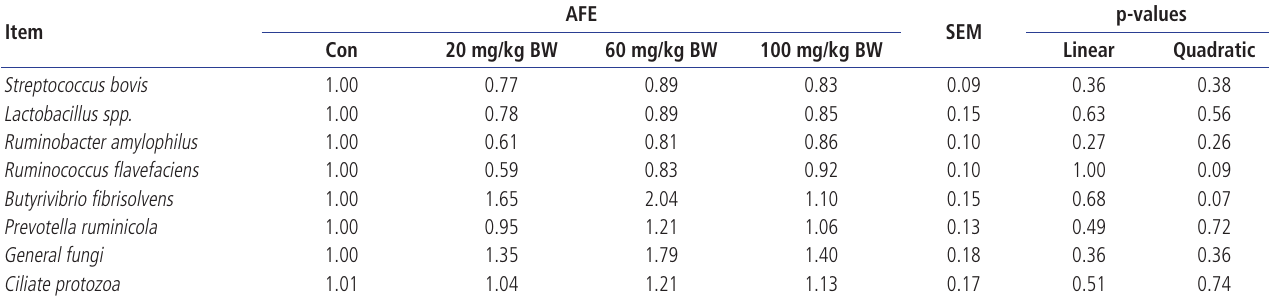
Table 9. Effects of AFE on relative expression of microbial gene Item